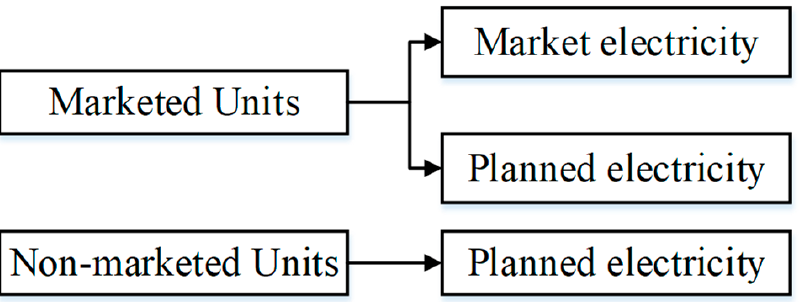
Figure 2. Energy composition for different type of generation units in the power system in which planned and market electricity are parallel.